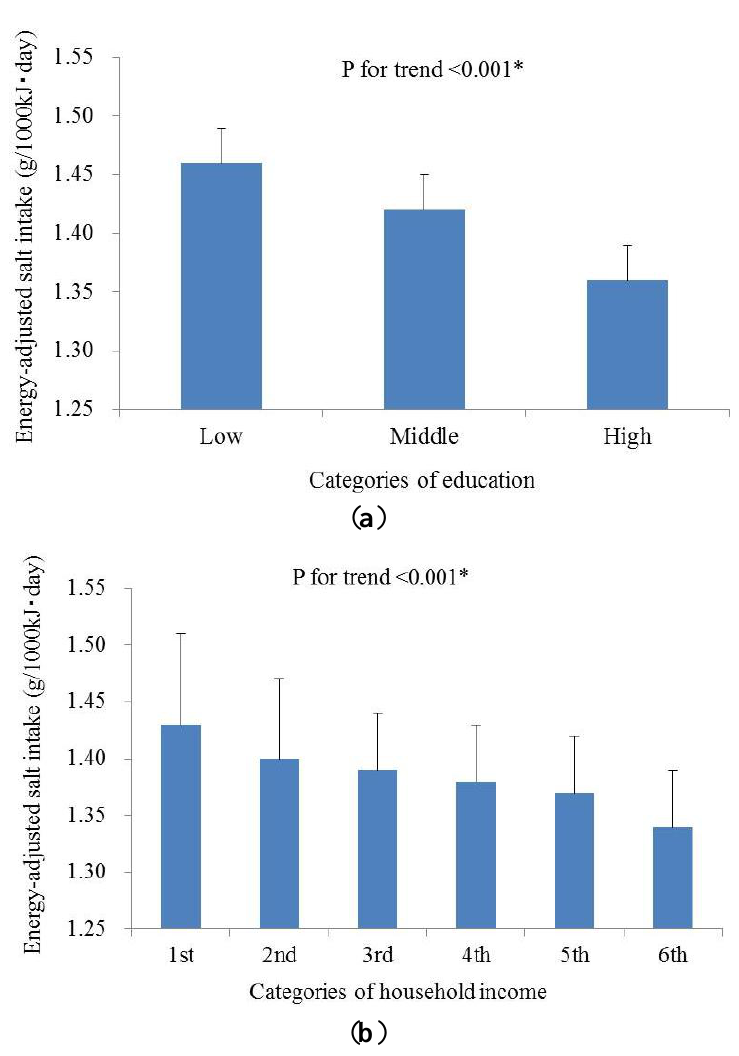
household incomes of participants: 1, <3.0 million yen/year; 2, 3.0–4.99 million yen/year; 3, 5.0–7.99 million yen/year; 4, 8.0–9.99 million